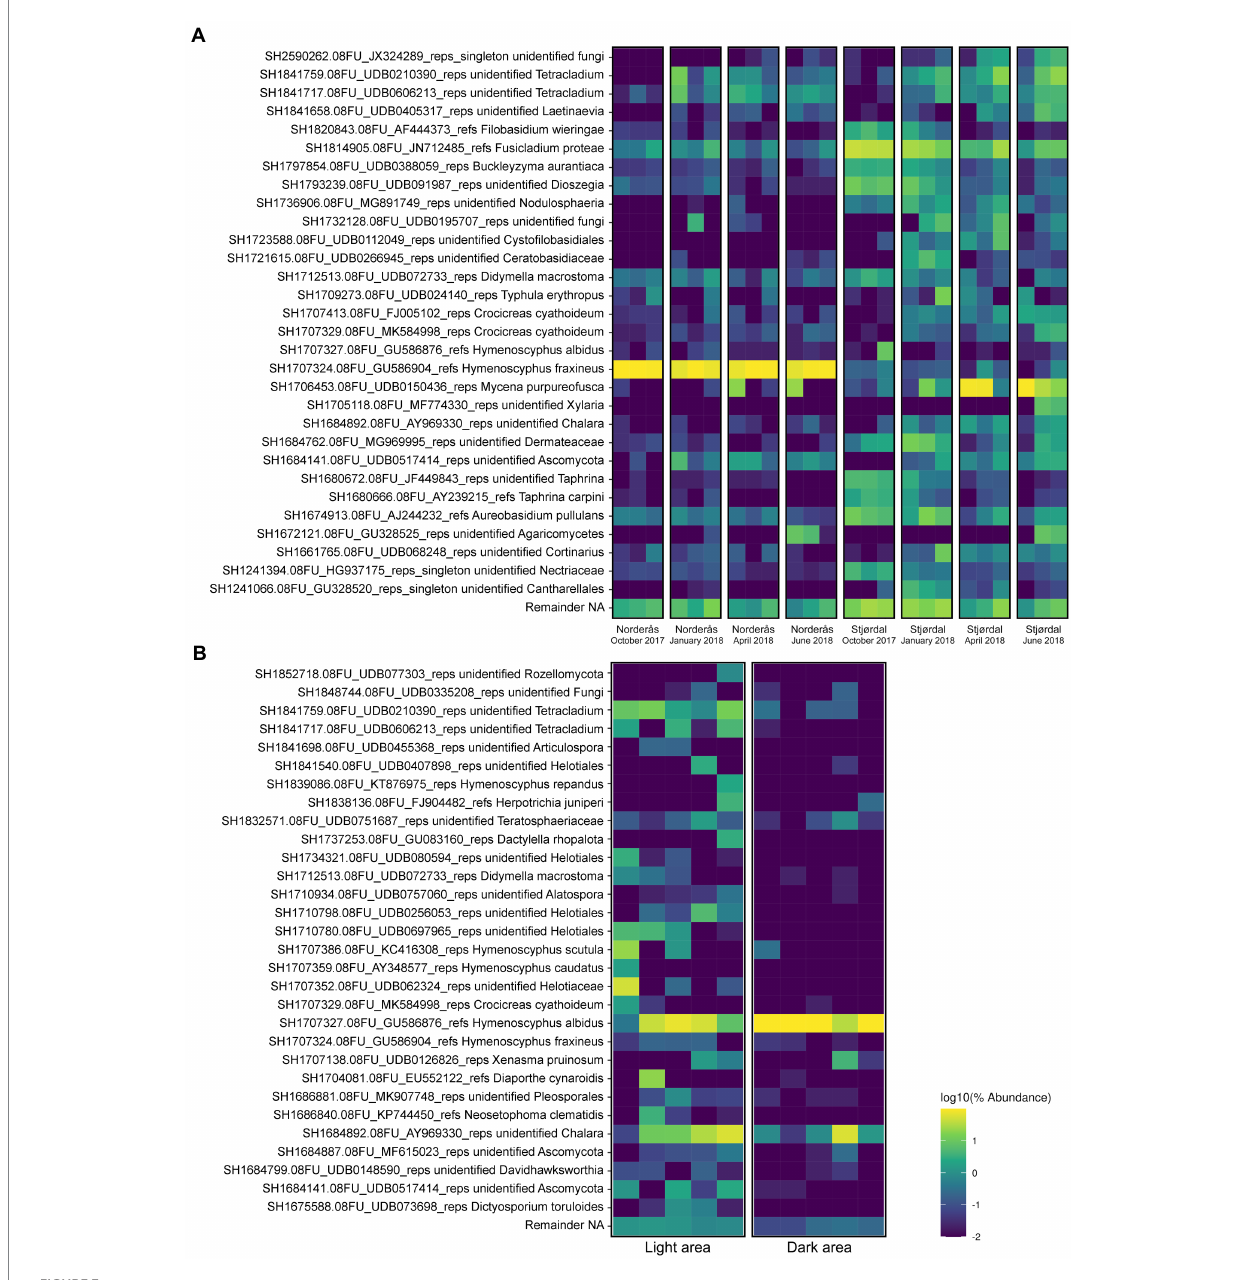
FIGURE 3 Top 30 highly abundant OTUs associated with (A) petioles from the diseased (Norderås) and healthy (Stjørdal) sites during overwintering in the period 2017–2018 and (B) the dark pseudosclerotial and adjacent light petiole areas from Stjørdal samples that hosted Hymenoscyphus albidus ascomata upon collection in